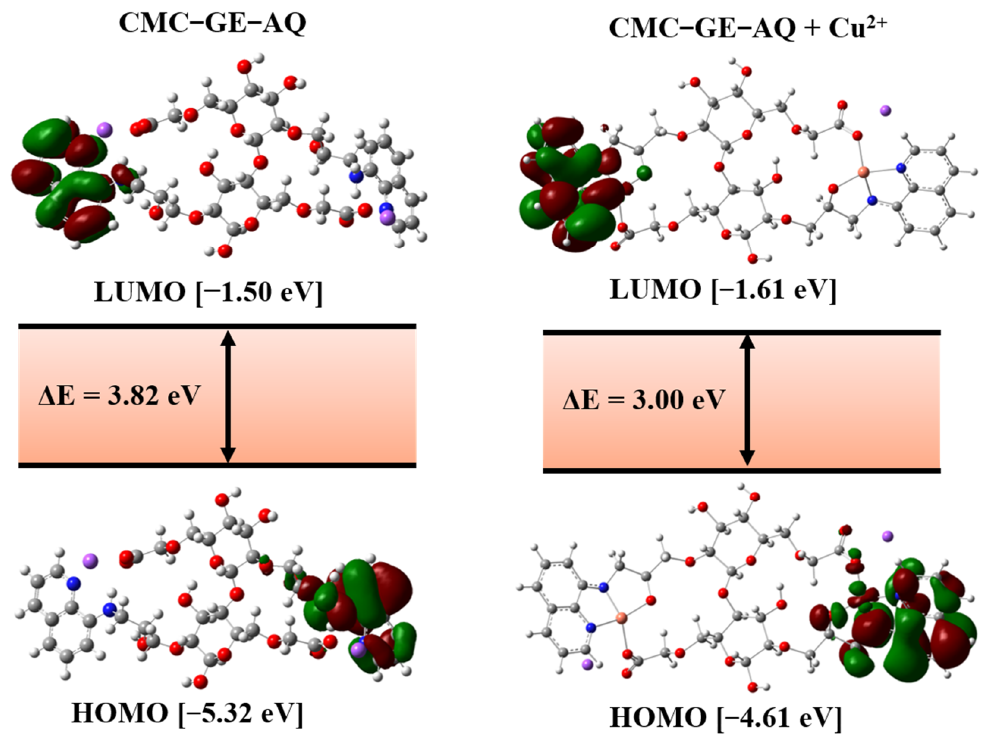
Figure 11. HOMO, LUMO and HOMO−LUMO energy gaps of the CMC−GE−AQ and CMC−GE−AQ + Cu 2+ complexes.